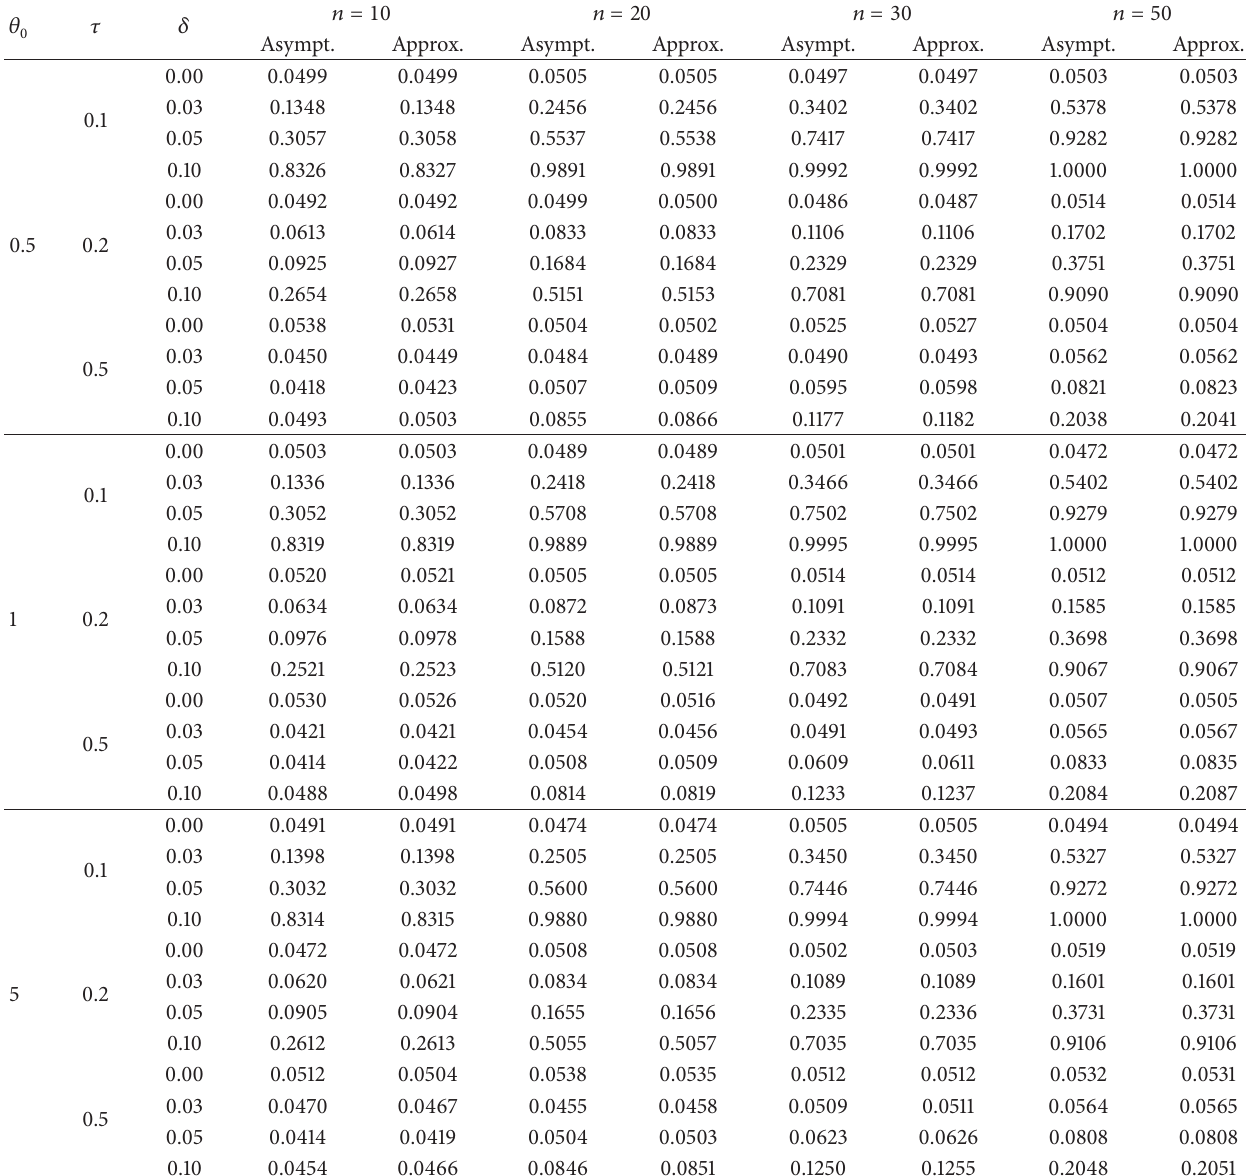
Table 3: The empirical type I errors and powers of the asymptotic test and the approximate